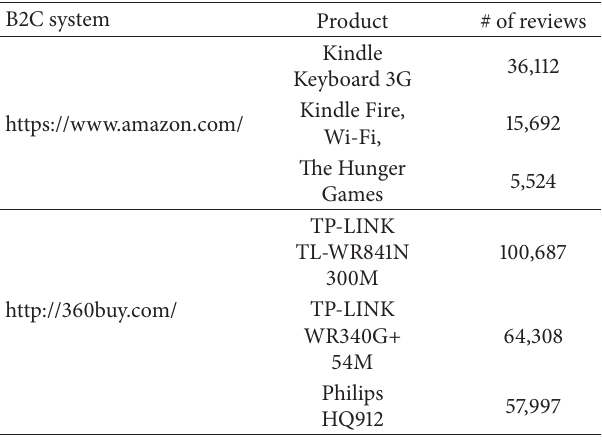
Table 1: Certain top reviewed items in https://www.amazon.com/ and